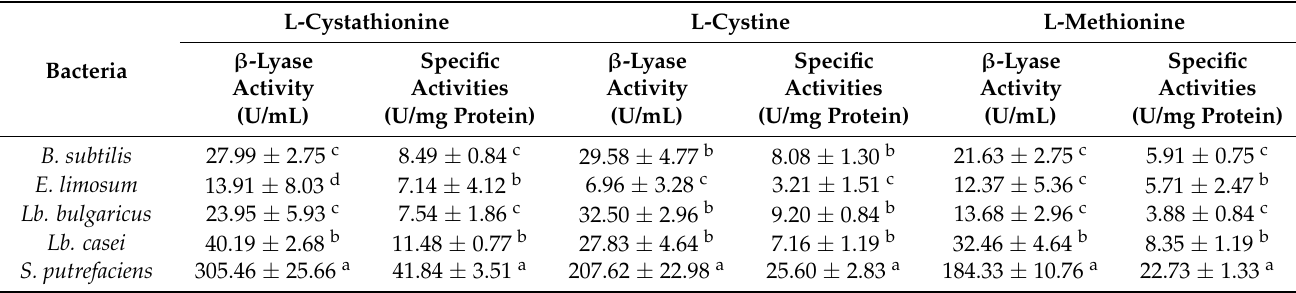
Table 2. The β -lyase activities for various substrates by various bacteria crude